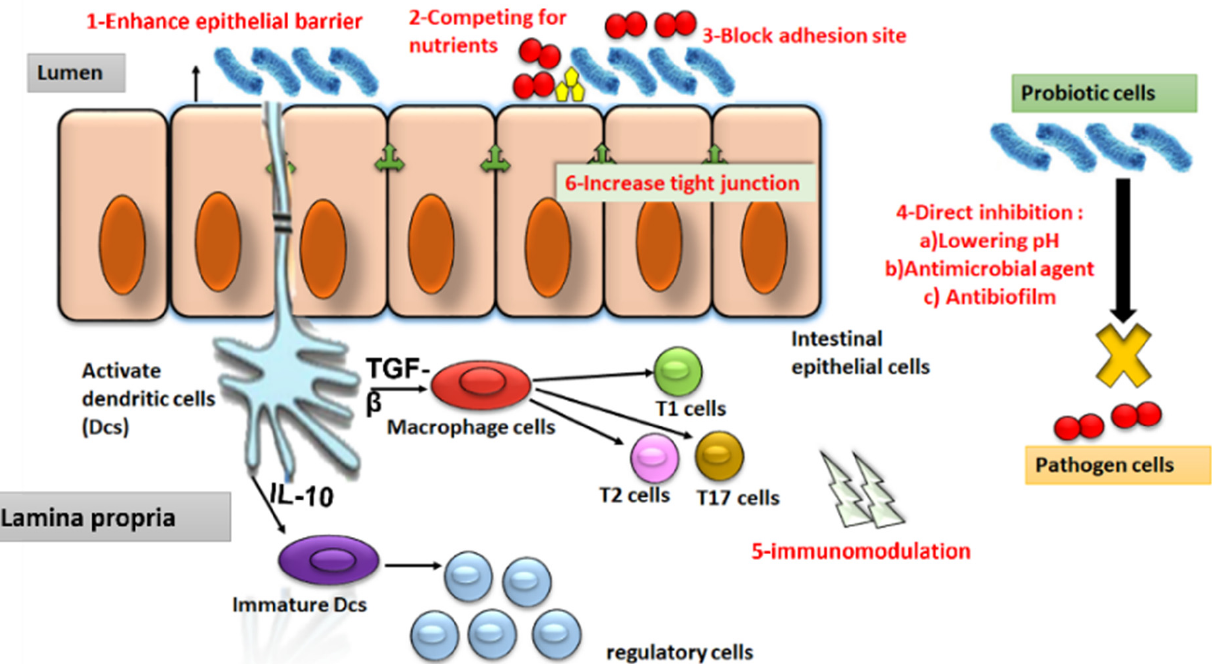
Figure 3. Mechanism of probiotics action.